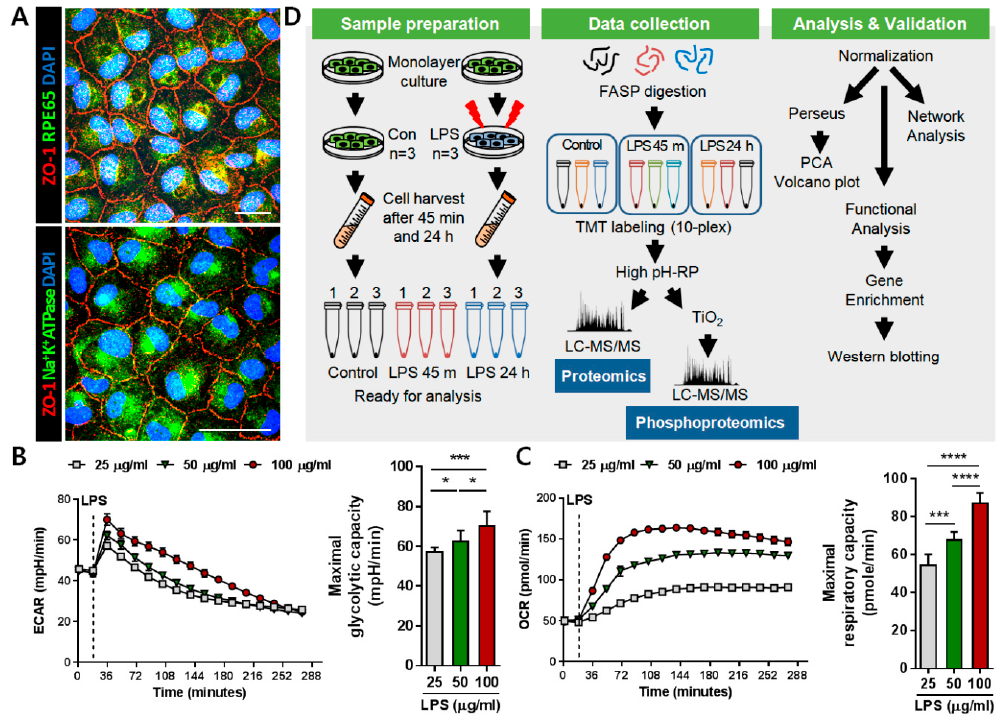
Figure 1. Experimental setup and workflow to investigate lipopolysaccharide (LPS)-stimulated ARPE-19 proteome and phosphoproteome. ( A ) Immunofluorescence images of polarized ARPE-19 cells stained for ZO-1 (red) and RPE65 (green) or Na + K + ATPase (green). Scale bar: 25 µ m. ( B , C ) Real-time assessing metabolic responses to di ff erent concentrations of LPS in ARPE-19 cells. Bars indicate means ± SEM. * p < 0.05, *** p < 0.001, **** p < 0.0001. ( D ) Pipeline for the tandem-mass tag (TMT)-based proteomic / phosphoproteomic approach to LPS-treated ARPE-19